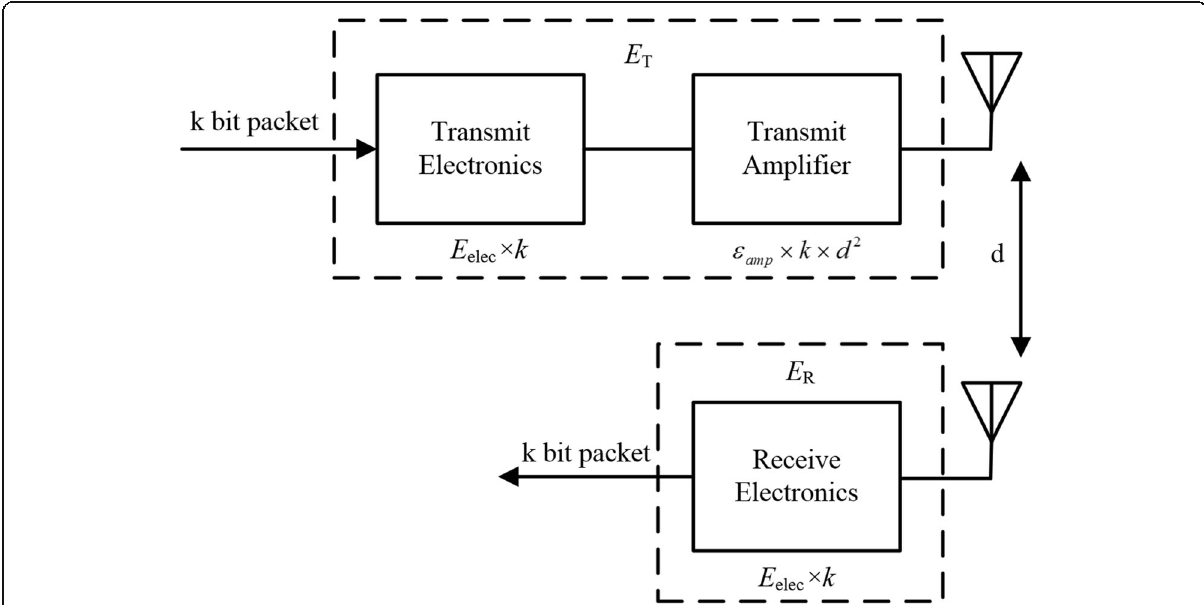
Fig. 2 Energy consumption model. This figure shows the first order radio model which is used as the energy consumption model that is considered in this paper. E elec is the amount of energy required to transmit and receive one bit message, and ε amp is the amount of energy required to amplify the transmitter signal. The energy consumption of transmission and reception are denoted as E T and E R ,